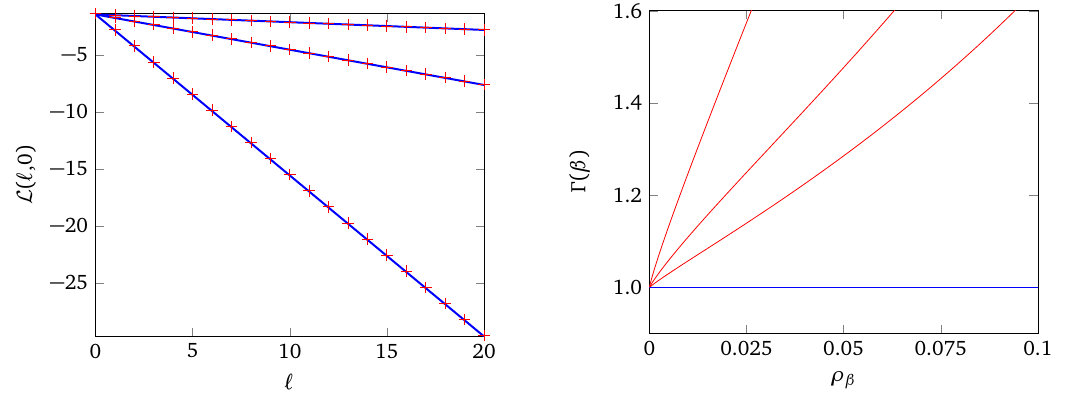
Figure 11: Left: L ( (cid:96) ,0 ) for h = 0.5 and β = 2,1,0.25 (top to bottom). Numerical results for a L = 200 site open chain are shown as red crosses and equation (143) by a continuous blue line. Right: Numerically determined Γ ( β ) as a function of ρ β for (cid:96) = 30 and h = 3 / 4,1 / 2,1 / 4 from top to bottom; in blue is the expected value as ρ → β